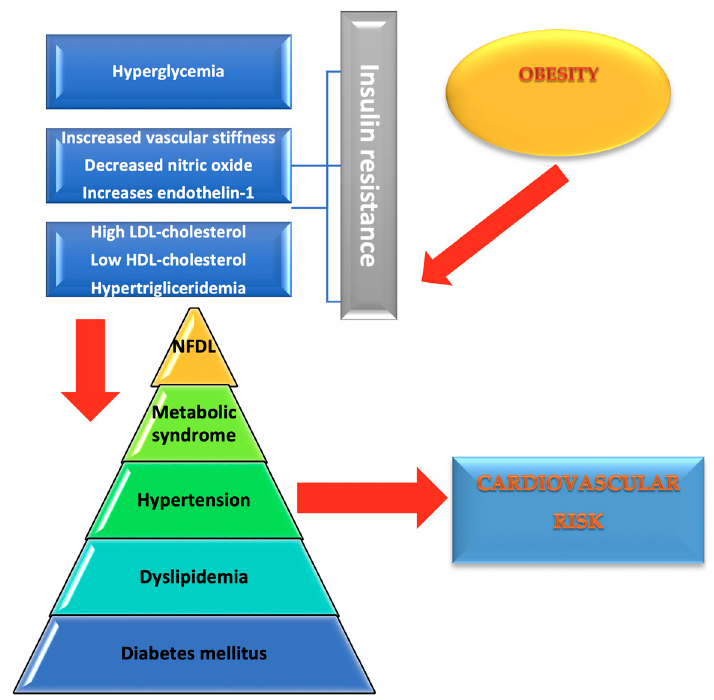
Figure 1. Pathophysiological alterations in obesity and diabetes mellitus.